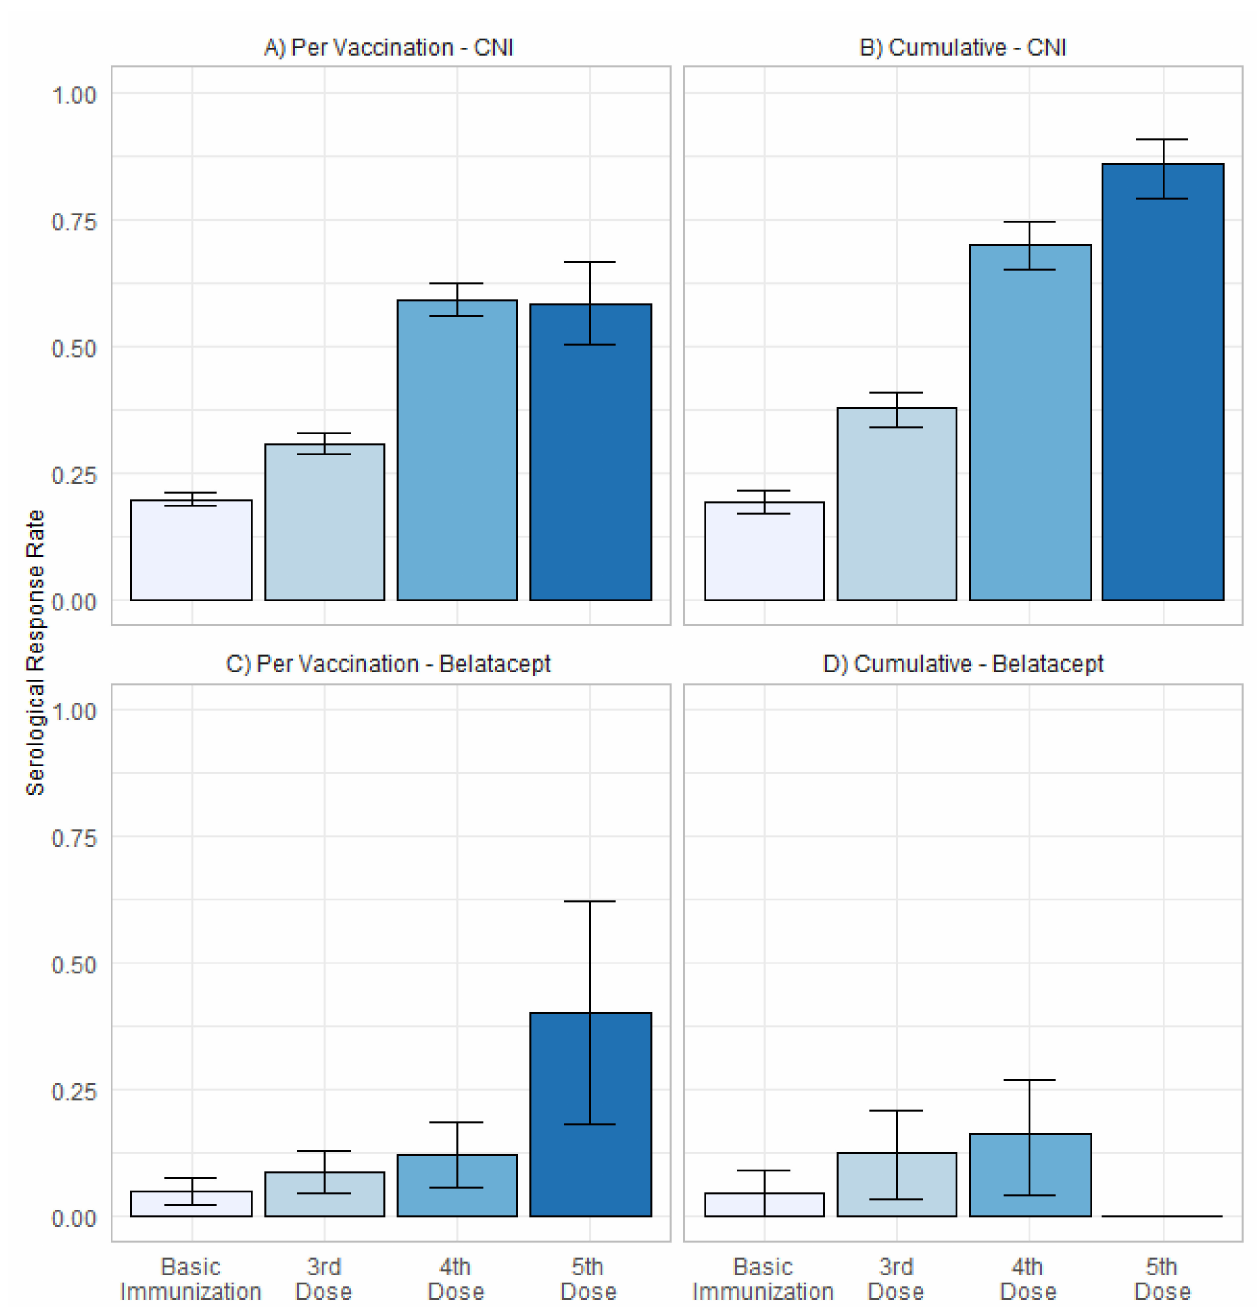
Figure 4. ( A ) Serological response rate per vaccination ( ± standard deviation) and ( B ) cumulative serological response rate ( ± 95% confidence interval) after up to 5 vaccinations in patients with CNI-based immunosuppression, as well as ( C ) serological response rate per vaccination ( ± standard deviation) and ( D ) cumulative serological response rate ( ± 95% confidence interval) after up to 4 vaccinations in patients with belatacept-based immunosuppression. Cumulative response rate after fifth vaccination is not shown for patients with belatacept, due to low patient count of 5 patients receiving fifth